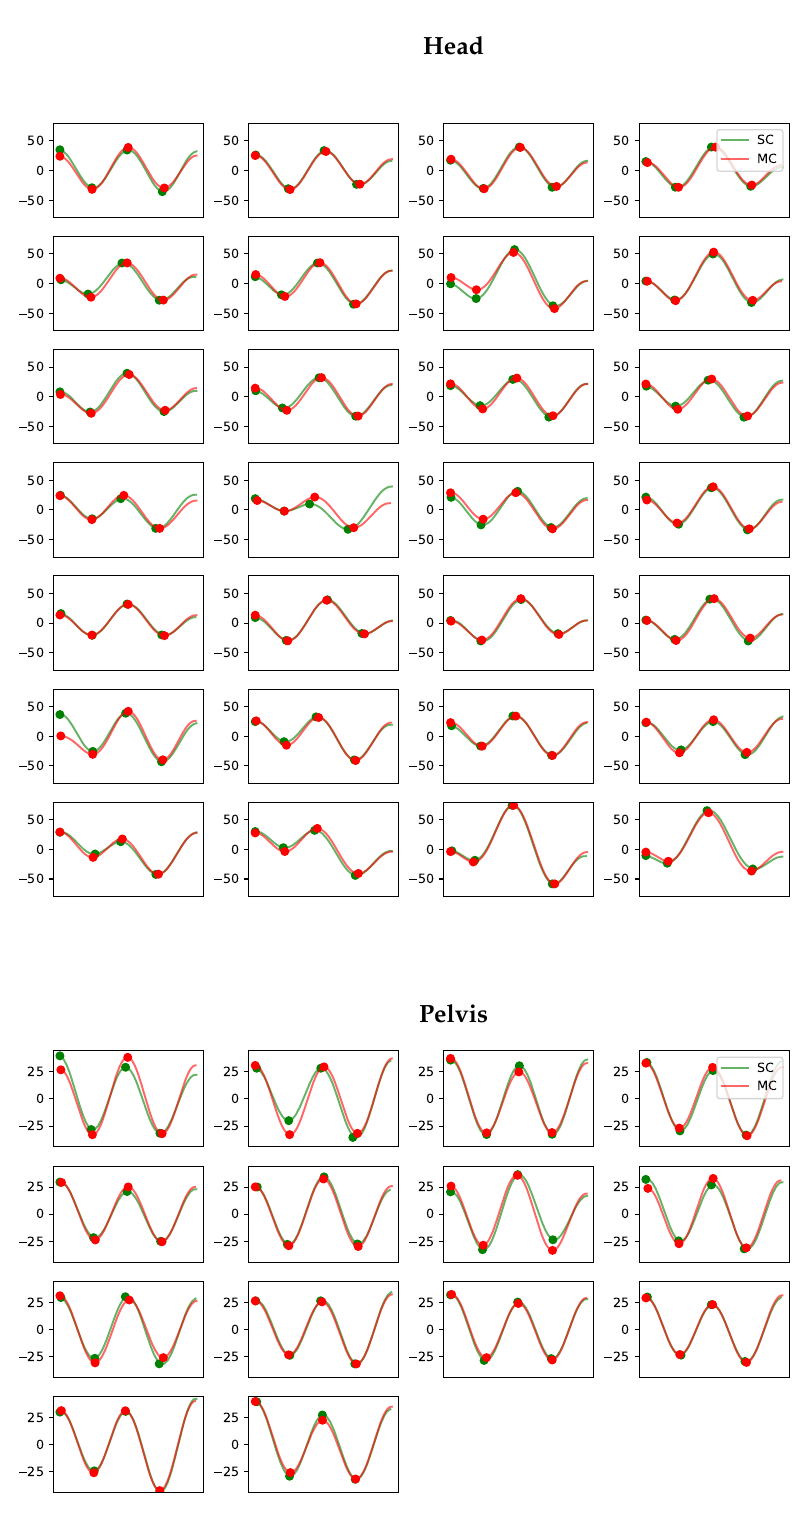
Figure A11. Vertical displacement signals per stride for the head and pelvis for horse 12. Each subplot contains the matched stride segments for the single-camera markerless system (SC) in green and the multi-camera marker-based system (MC) in red. The y-axis shows the vertical displacement in millimeters. The four dots on each curve indicate the positions of the two peaks and two valleys extracted using the approach in Section